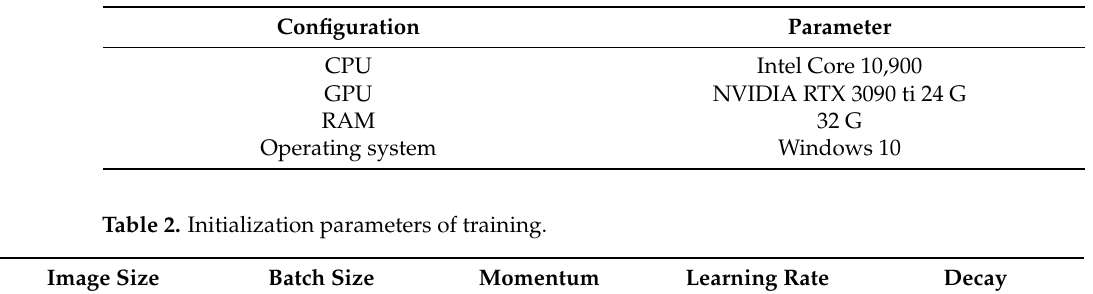
Table 1. Experimental configuration and parameters.